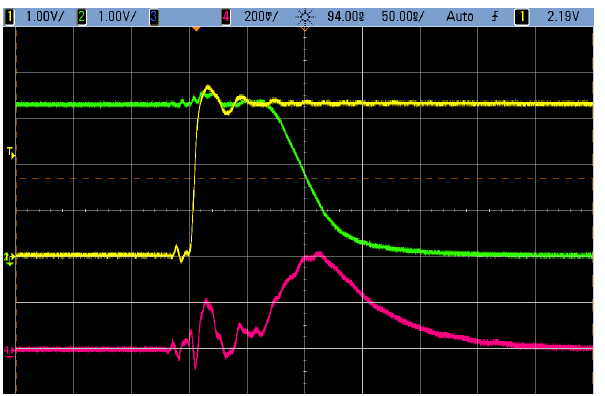
Figure 2. A CMOS inverter current consumption. The yellow line is the inverter input, the green line is the inverter output. The pink line is the current consumption, where peaks during the transition are clearly